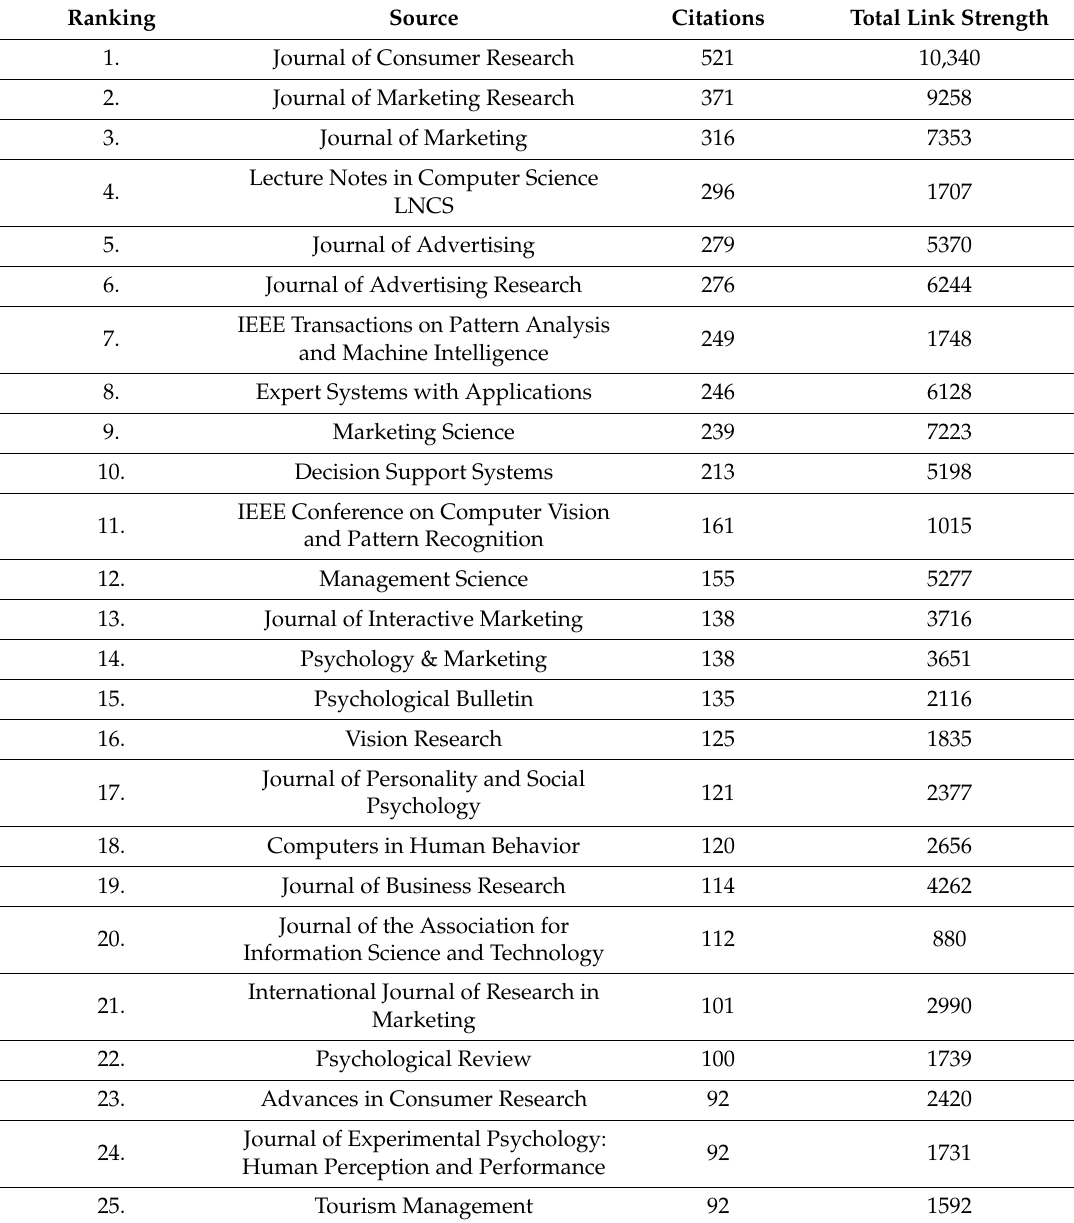
Table 4. The Top 25 Co-Citation analysis (sources). The relatedness of items is determined based on the number of times they are cited together. Minimum number of citations of a source (75). Of the 11,186 sources, 34 met the